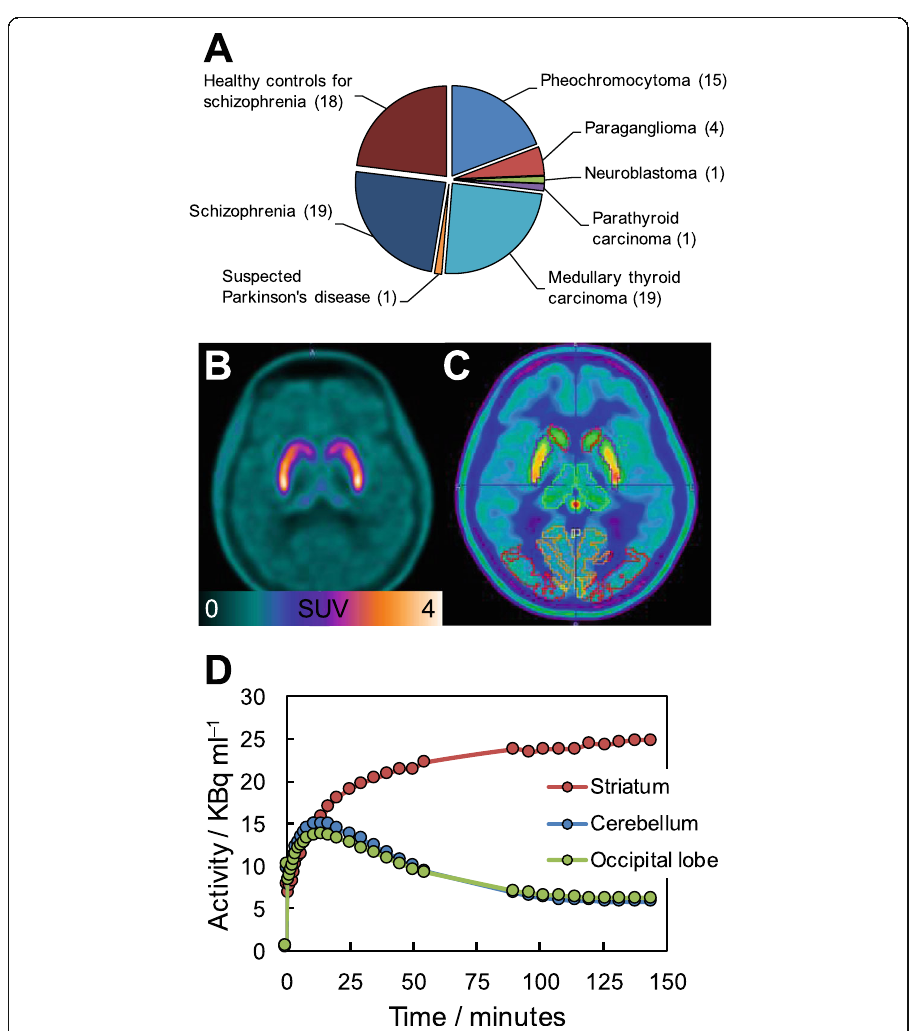
Fig. 3 Clinical data from HUH. A The composition of the subjects undergoing PET/CT scans with [ 18 F]1 from 2017 until March 2020. B , C , and D A dynamic 2.5-h [ 18 F]1 scan of the brain in a 22 yo female with schizophrenia, showing high tracer uptake in the striatum with a high target-to-background ratio. For the time activity curves in ( D ), the time scale starts at the start of the first